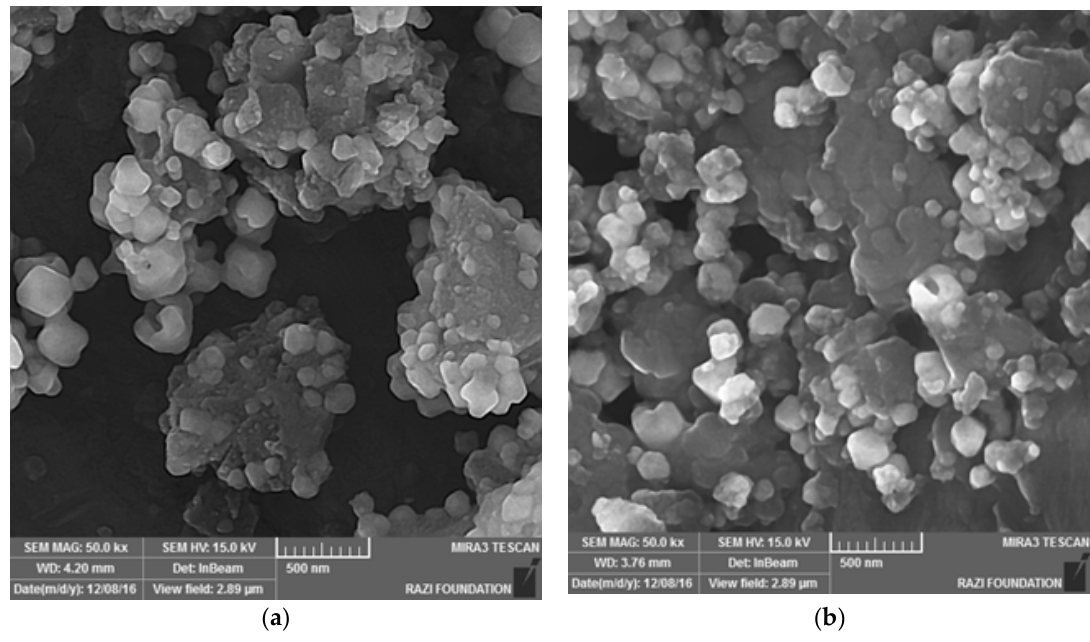
Figure 4. FESEM images of fresh ( a ) 25Ni/SBA ‐ 16 and ( b ) 25Ni ‐ 2.5Y/SBA ‐ 16 oxygen carriers.